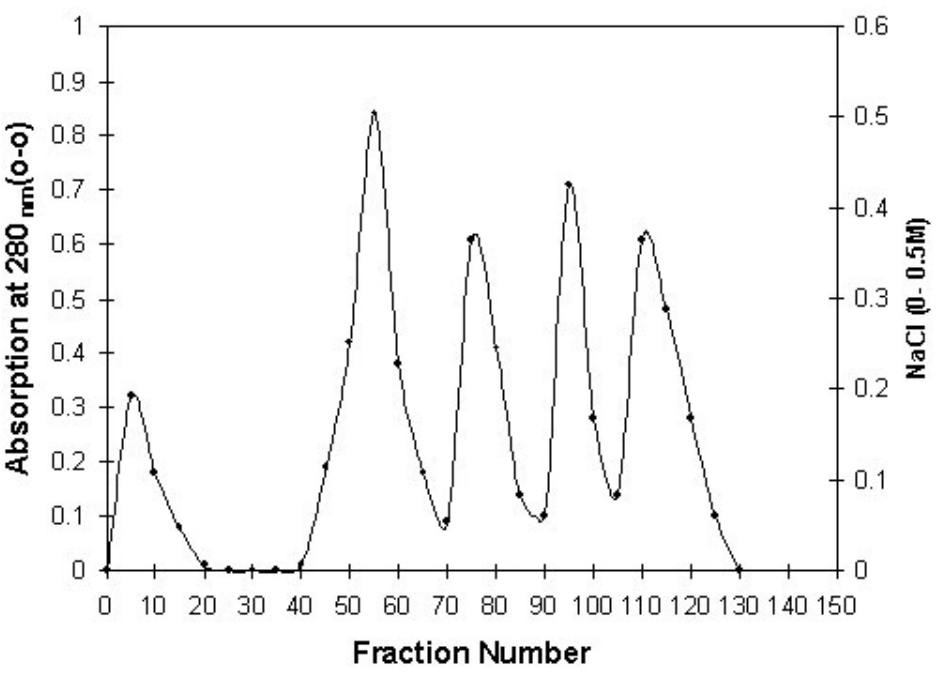
Figure 1: CM-Sephadex C-25 column chromatography of Palamneus gravimanus venom. The crude venom was dissolved in 5 ml of 0.05M Tris-HCl buffer, pH 8.5, and loaded on a previously equilibrated CM-Sephadex C-25 column (1.5 x 18 cm). After washing the column with 500 ml of the Tris-HCl buffer, pH 8.5, the venom components were eluted using Tris-HCl with a linear gradient of 250 ml 0-0.5 M NaCl at a flow rate of 40 ml/h, and 4.0 ml fractions were collected. Proteins of the fractions were monitored at 280